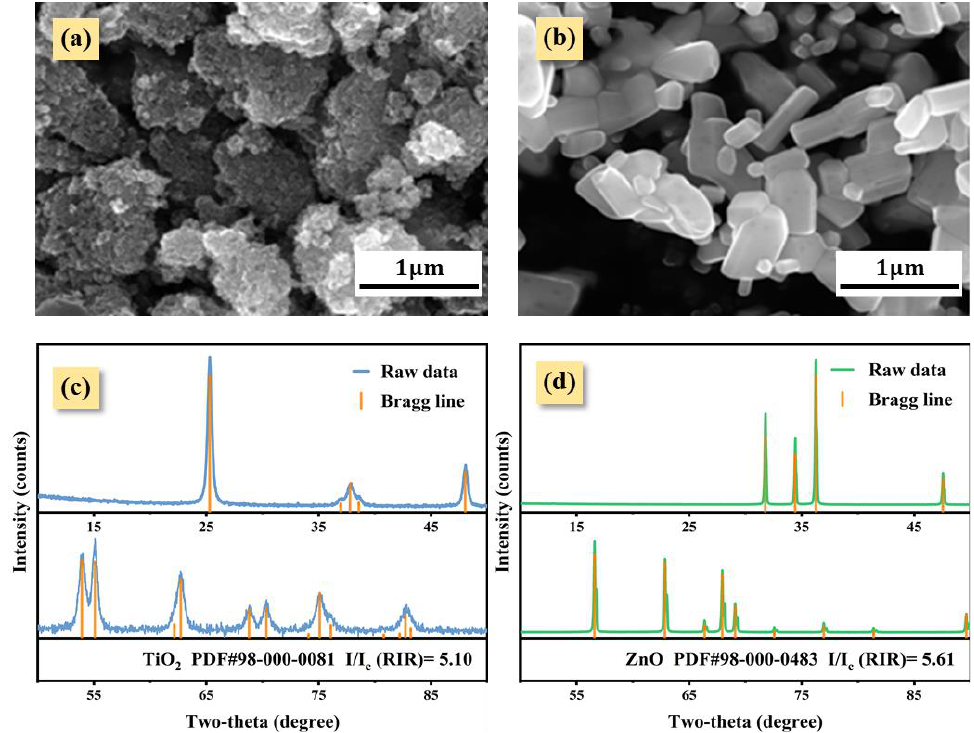
Figure 2. The SEM morphologies ( a , b ) and XRD patterns ( c , d ) of nano-TiO 2 powder and ZnO powder. The information of PDF card and RIR value based on Jade-standard software were listed [12].